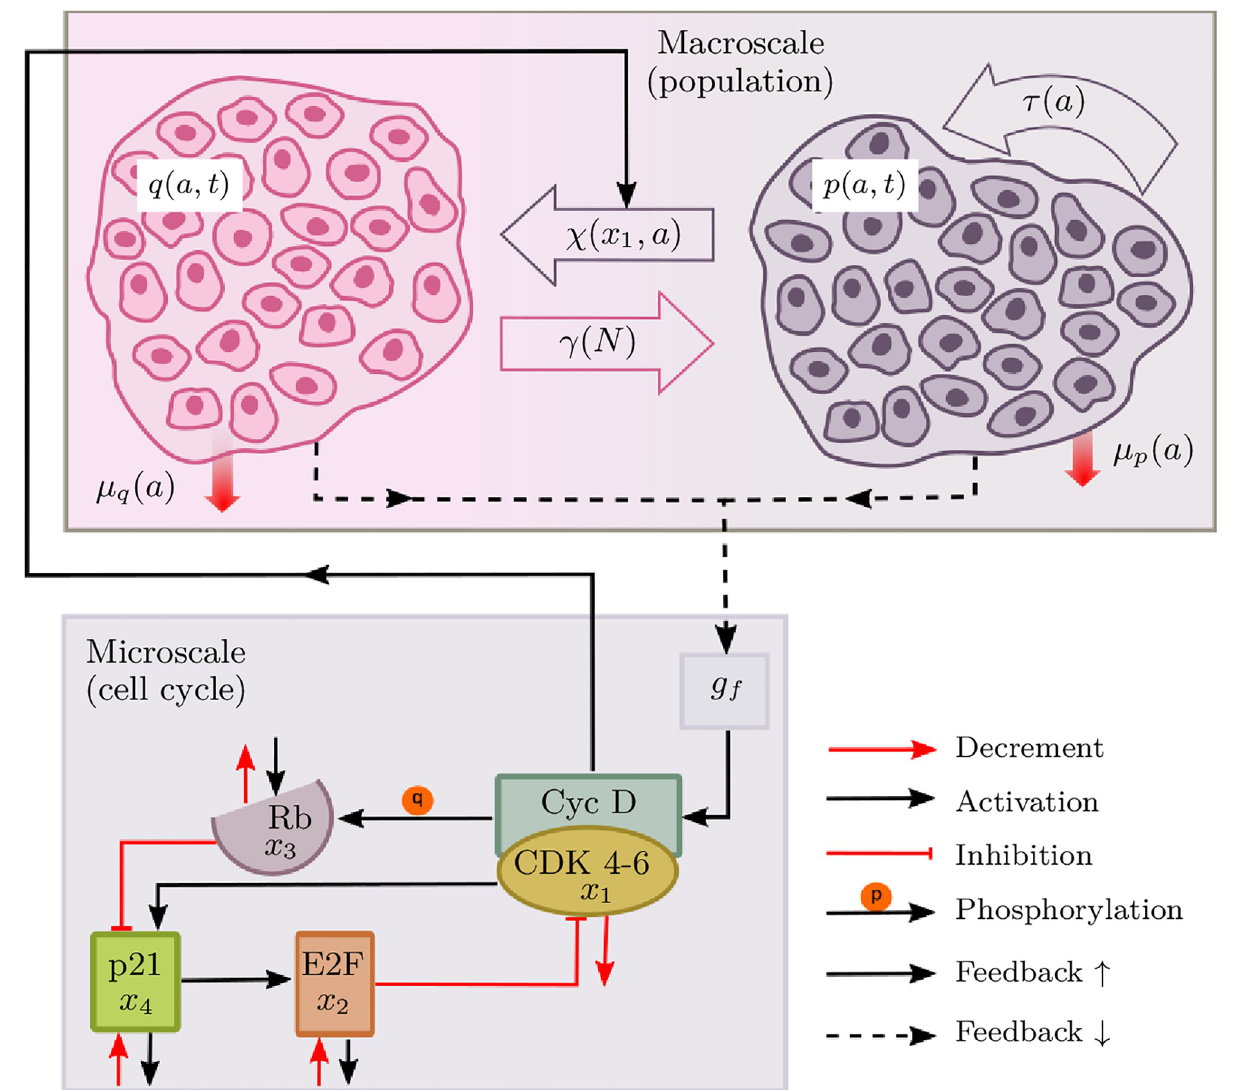
Fig 1. Model schematics. In the macro-scale, two subpopulations are proliferating and quiescent cells with various transition effects given by χ , τ , γ , and μ functions. At the bottom, the microscale is represented with all four protein states and their interactions which are explained using legends in the bottom left. The feedback from the macroscale, in the form of growth factors g f , manipulates the cell-cycle (microscale). The feedback loop is closed by the rate χ (corresponds to the rate of cells transitioning from proliferating to quiescent phase), determined by the protein dynamics at the microscale.